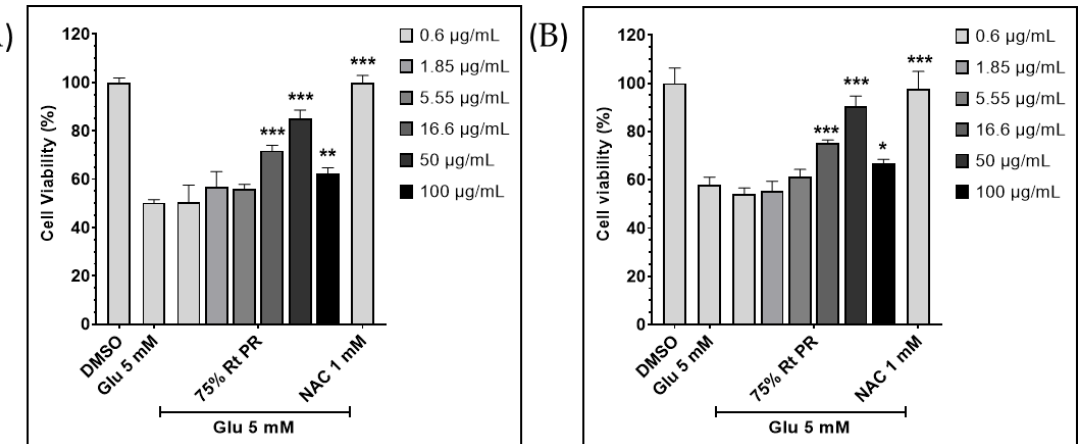
Figure 1. The 75% EEPF prevents glutamate induced neuronal cell death. ( A ) Relative cell survival of HT22 hippocampal neuronal cell after treatment with 5 mM of glutamate (Glu) in the presence or absence of 75% EEPF. Calcein-AM stained live cells were counted by Operetta image analysis system. ( B ) Relative cell survival of HT22 hippocampal neuronal cells after treatment with 5 mM of glutamate in the presence and absence of 75% EEPF. Tetrazolium based EZ-Cytox reagent was used for measuring cell viability, NAC; n-acetylcysteine. Data bar graphs are presented as means ± SD, n = 4, and the p values *** p > 0.001, ** p > 0.01, * p > 0.05.